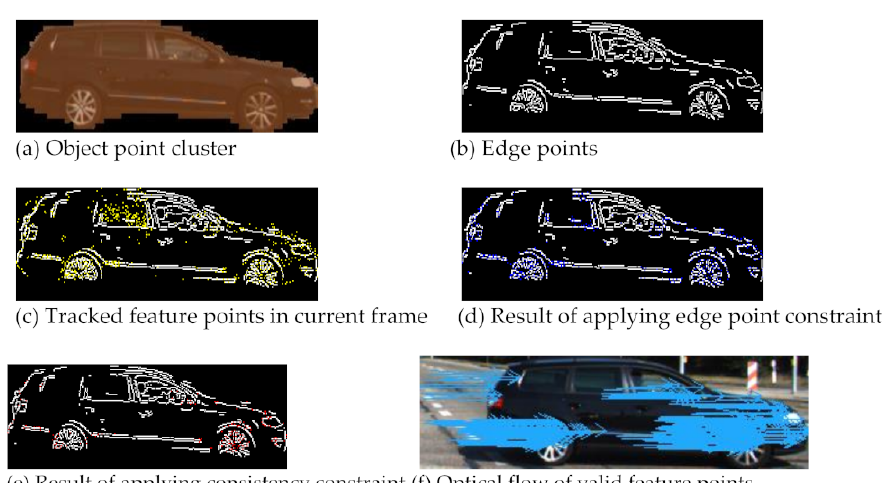
Figure 6. The processing of the feature-point filtering. ( a ) Object point cluster; ( b ) Edge points; ( c ) Tracked feature points in current frame; ( d ) Result of applying edge point constraint; ( e ) Result of applying consistency constraint; ( f ) Optical flow of valid feature